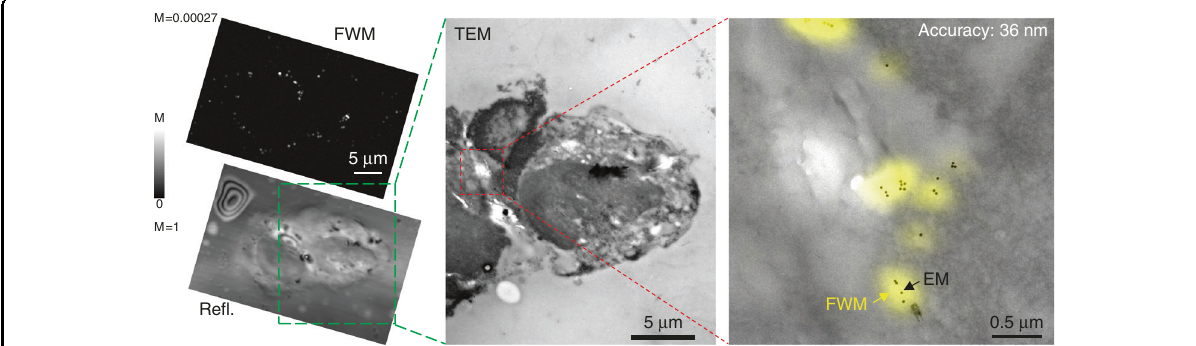
Fig. 6 CLEM correlation accuracy with 3D FWM analysis. FWM-CLEM using 10 nm-radius AuNPs bound to EGF internalised in HeLa cells whereby the coordinates of the particles in FWM are measured in 3D via a z-stack. A large FWM overview in 2D with corresponding re fl ection image measured simultaneously is shown on the left (linear grey scales are from 0 to M as indicated; M = 1 corresponds to 33 mV rms detected; see Methods for details of the excitation and detection conditions). A TEM overview of the same region is shown in the centre, as indicated by the green dashed frame. On the right, an overlay of FWM fi eld amplitude (yellow) and TEM image (grey) is shown for the region highlighted by the red dashed frame, where FWM is a maximum amplitude projection from a 3D z-stack (50 nm step size in z ). AuNPs form small clusters and are no longer resolved as individual particles in FWM. The centroid position of each cluster was determined in 3D from the FWM z-stack (see Methods), and its 2D in-plane coordinates were compared with the position of the geometrical centre of the cluster in TEM (which is a 2D transmission projection) for the correlation analysis. The resulting correlation accuracy from the comparison of the six clusters shown in the fi gure is